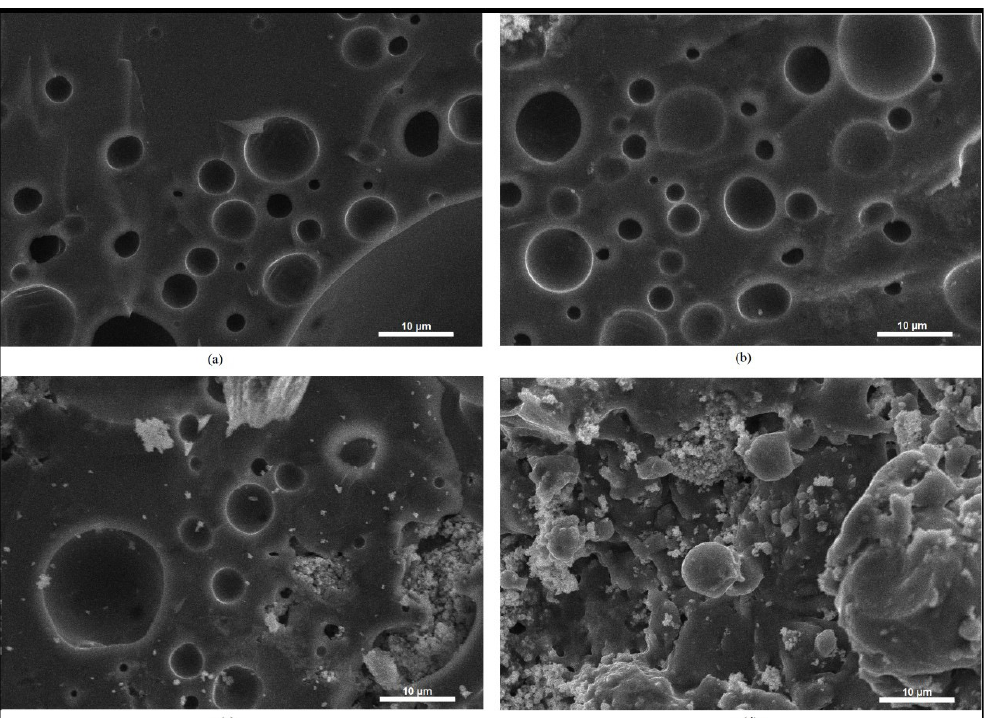
Figure 4. SEM photomicrographs of the glass-ceramic of the fracture surfaces of sintered samples at 800 ºC: (a) 0, (b) 5, (c) 10, (d) 15 wt% of Nb O 2 5